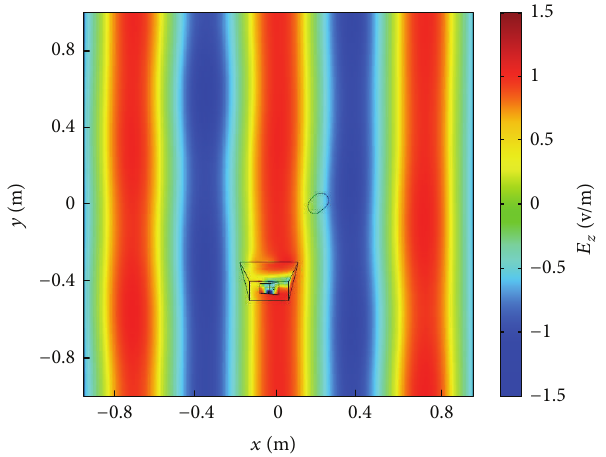
Figure 8: Electric field distribution of an object with an arbitrary